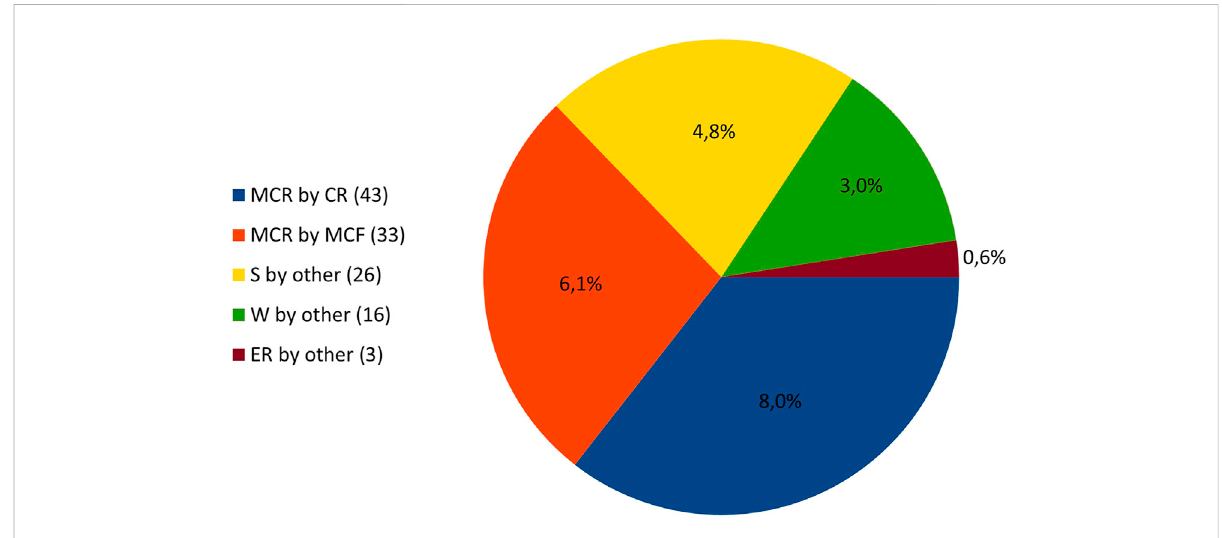
FIGURE 13 Material type attribute values exchanged in the remote